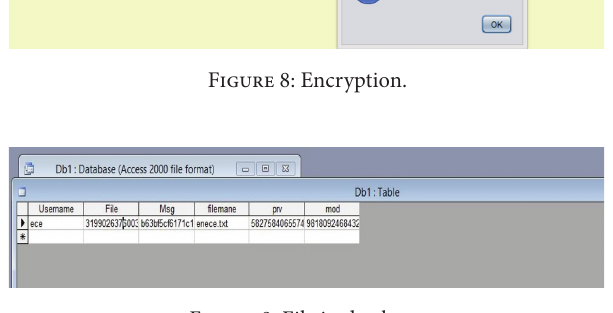
Figure 9: File in database.